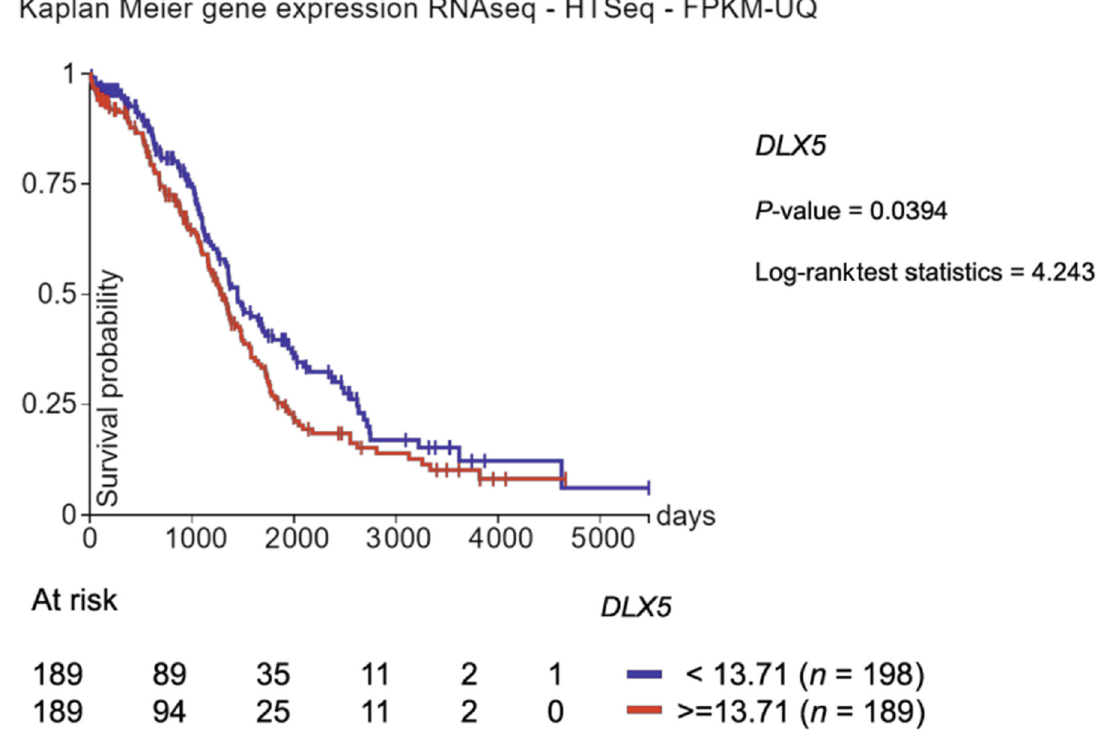
Figure 8. DLX5 is a poor prognosis marker in ovarian cancer. The RNA expression level of DLX5 in The Cancer Genome Atlas (TCGA) indicate that higher expression of DLX5 transcripts is associated with poorer survival in ovarian patients. HTSeq-FPKM-UQ = High Throughput Sequencing-Fragments Per Kilobase of transcript per Million mapped reads-Upper Quartile.